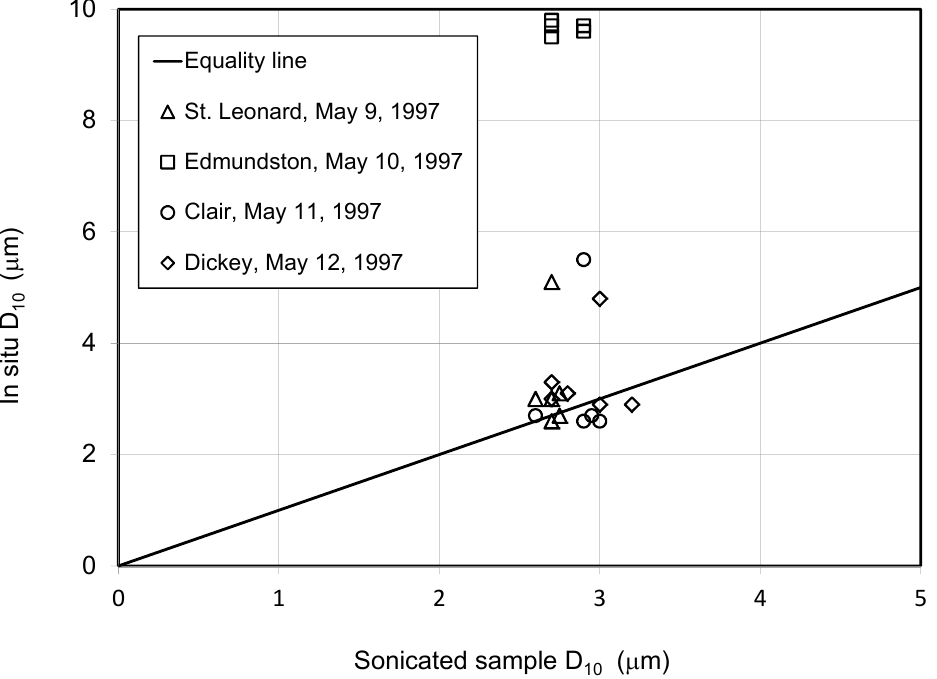
Figure 8. Comparing in situ sediment size to primary particle size: ninetieth percentile. From [16]. Crown copyright, published by Elsevier.